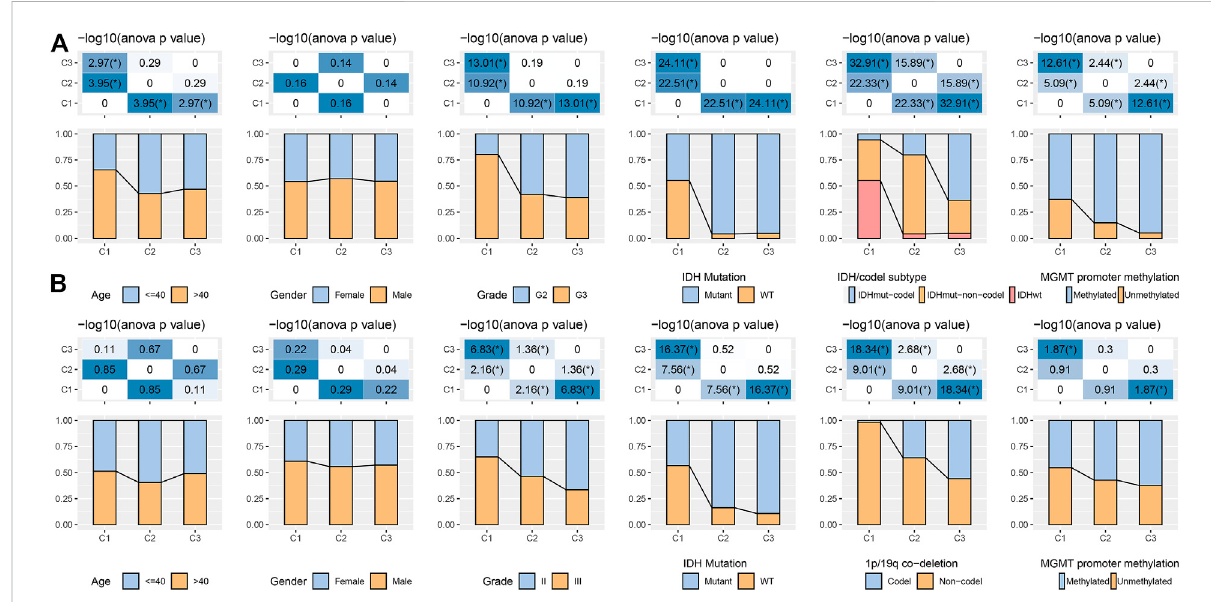
FIGURE 2 Distributioncharacteristicsofdifferentmolecularsubtypesineachclinicalvariable (A) Clinicopathologicalcharacteristicsofmolecularsubtypes intheTCGAdataset. (B) Clinicopathological characteristicsofmolecularsubtypes intheCGGA cohort;therein, thelower half showstheproportion, and the upper half shows the statistical signi fi cance of the difference in distribution between the two -log10 ( p